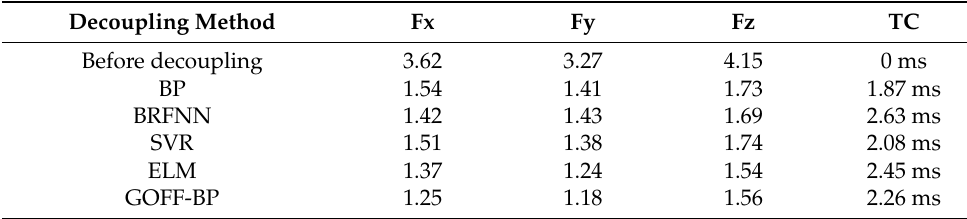
Table 1. Comparison of maximum type I errors of decoupling algorithm.